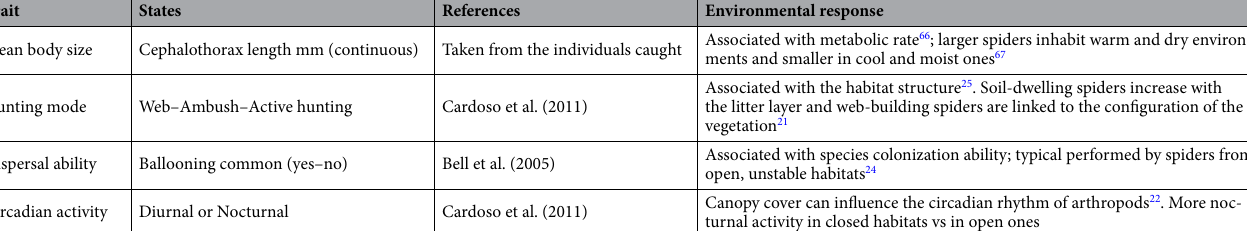
Table 1. Spiders functional traits specification with the respective environmental response association.